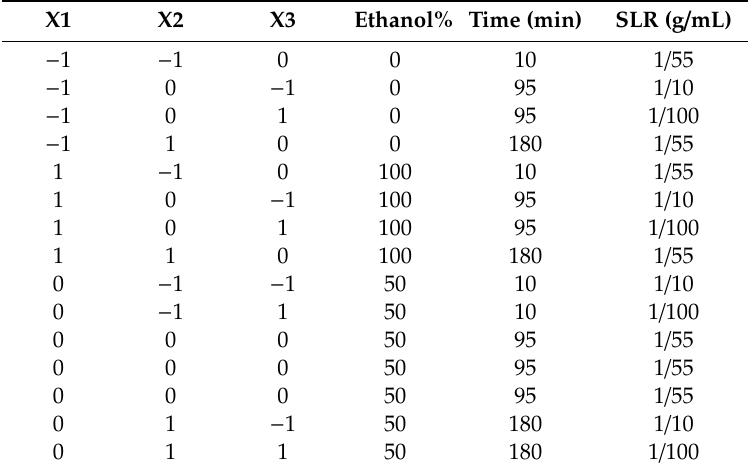
Table 3. Box-Behnken design layout and legend used in the extraction optimization procedure